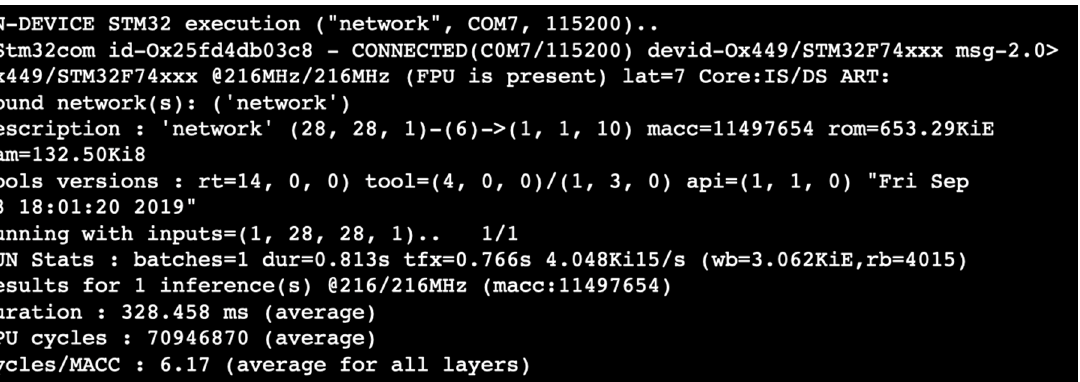
Figure 10. Inference details. Table 7. Time contribution of each layer.